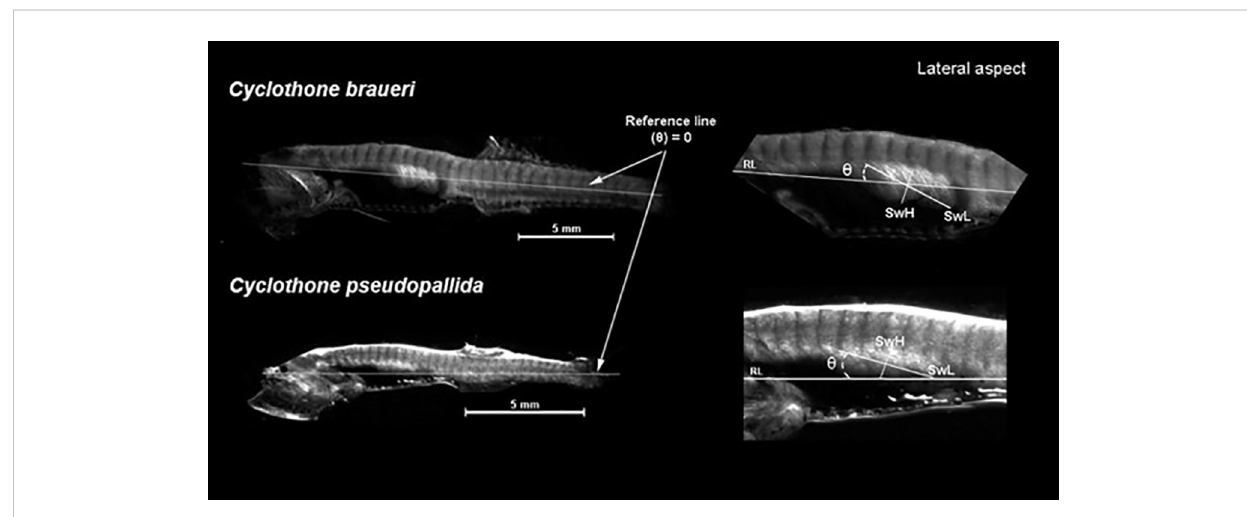
FIGURE 2 Cyclothone spp. swimbladder measurements performed with a microscope. SwL is swimbladder length; SwH is swimbladder height; SwW is swimbladder width; and q is swimbladder angle. RL is the reference